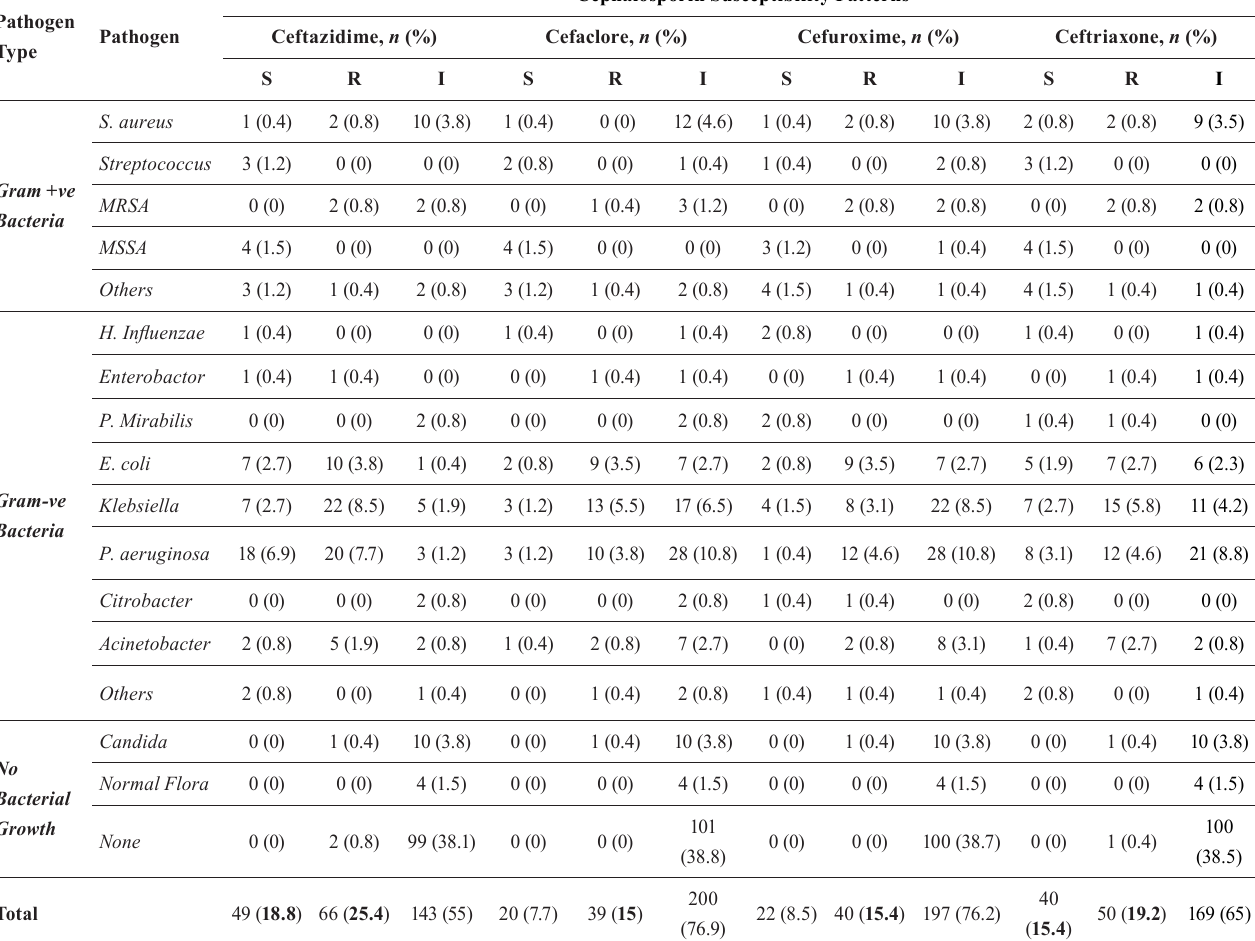
TABLE III - Cephalosporin Susceptibility Patterns against Respiratory Tract Pathogens